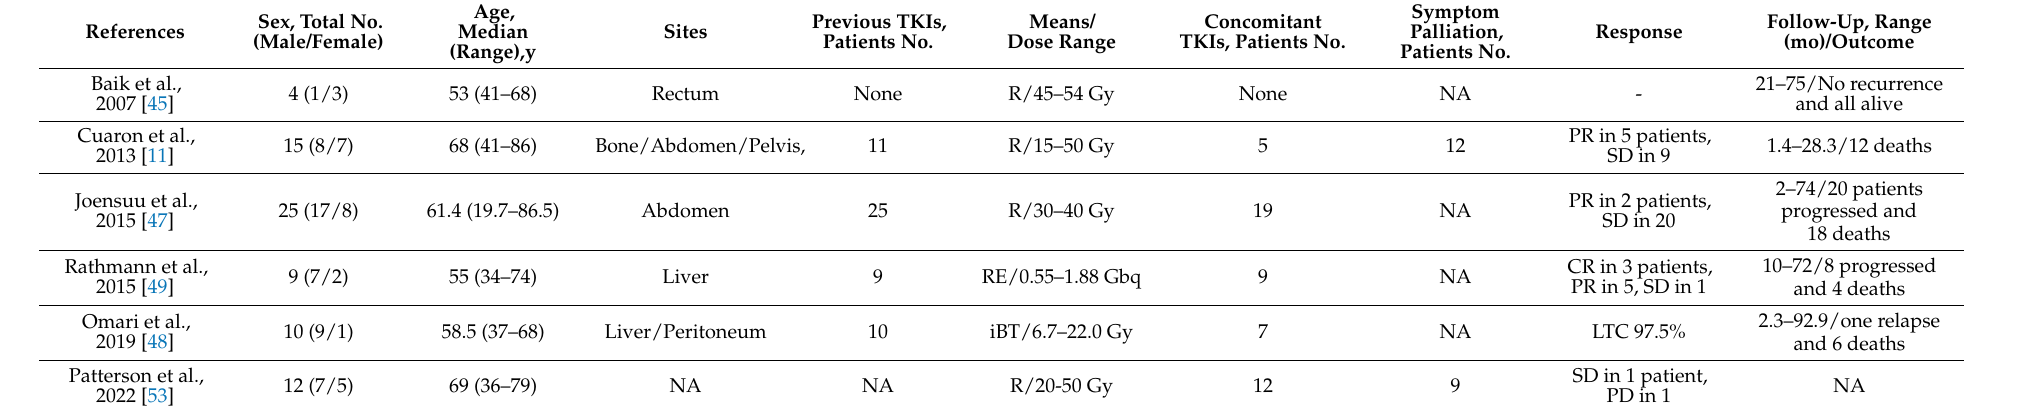
Table 2. Description of the case series treated by